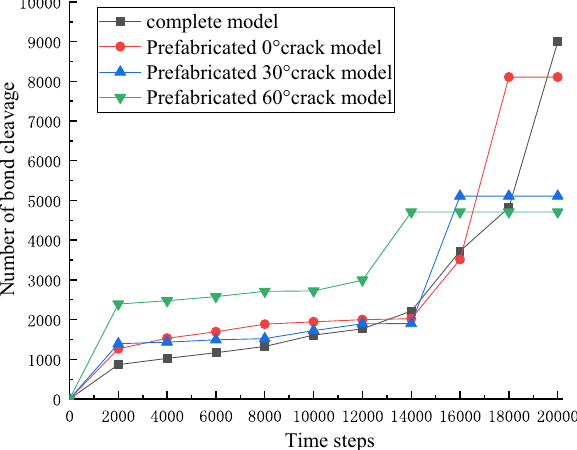
Figure 12. Number of bond cleavages per 1,000 steps for different models.